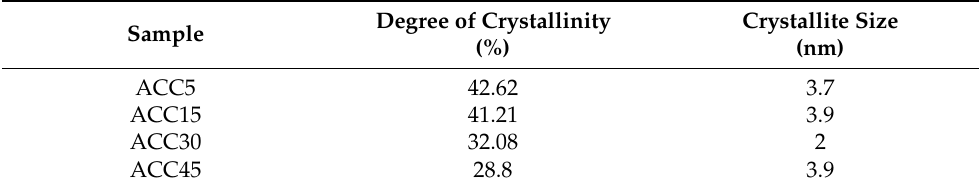
Table 4. Degree of crystallinity and crystallite size of the ACCs of the ACC films.